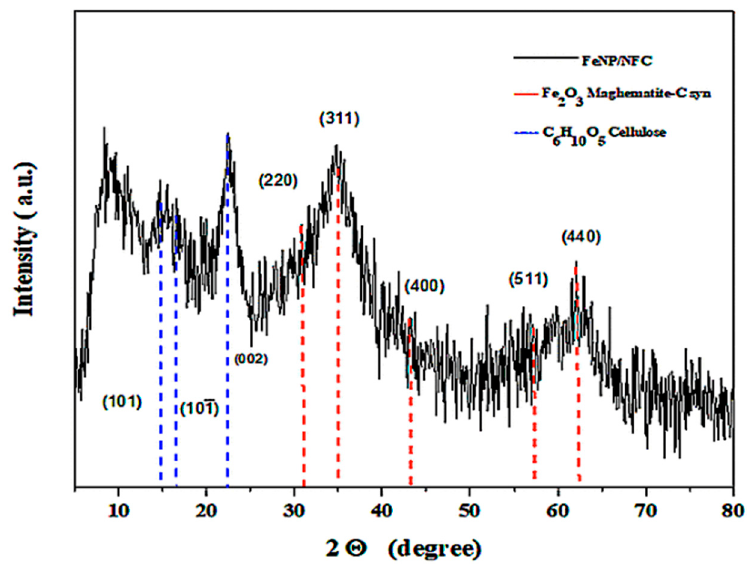
Figure 7. X-ray Diffraction (XRD) patterns of the FeNP/NFC, prepared with Moringa leaf extract. It is difficult for chemical reactions to take place in the crystalline region because of its stable structure. Hence, it becomes an easily accessible and penetrable amorphous structure, increasing iron nanoparticles’ introduction [4,73]. XRD patterns show peaks re- lated to amorphous and crystalline compounds (Figure 7). The nanoparticles in the mate- rial presented peaks at around 30° to 62°, which could be due to crystalline materials on organic